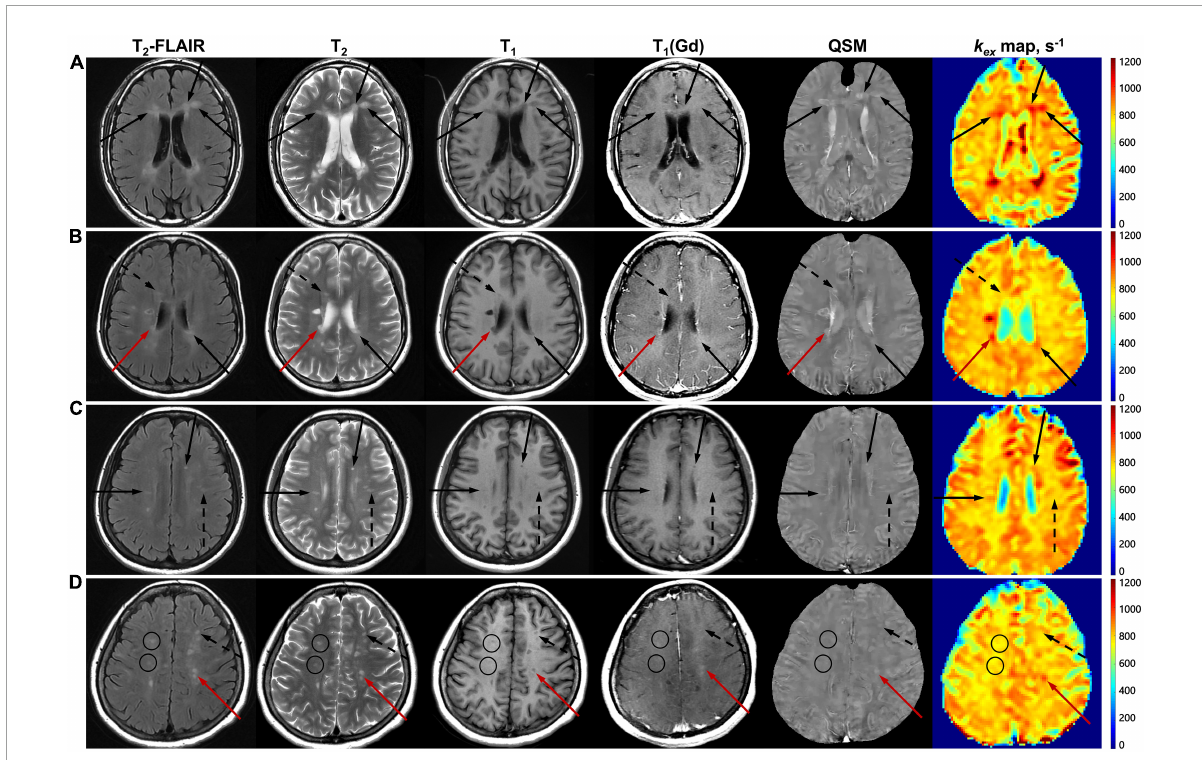
FIGURE4 Gd + lesions and the three patterns of Gd – lesions on multimodal MRI. Images are from Patient No. 20 (A) , No. 13 (B) , No. 11 (C) , and No. 27 (D) , whose disease duration was 0.5, 1, 2, and 8 years, respectively. Gd + lesions are indicated with red arrows (B,D) . Pattern I of Gd – lesions, which are k ex + and QSM + , are indicated with black arrows (A–C) . Pattern II of Gd – lesions, which are either k ex + and QSM – , or k ex – and QSM + , are indicated with black dashed arrows (B–D) . Pattern III of Gd – lesions, which are k ex – and QSM – , are indicated with black circles (D) .